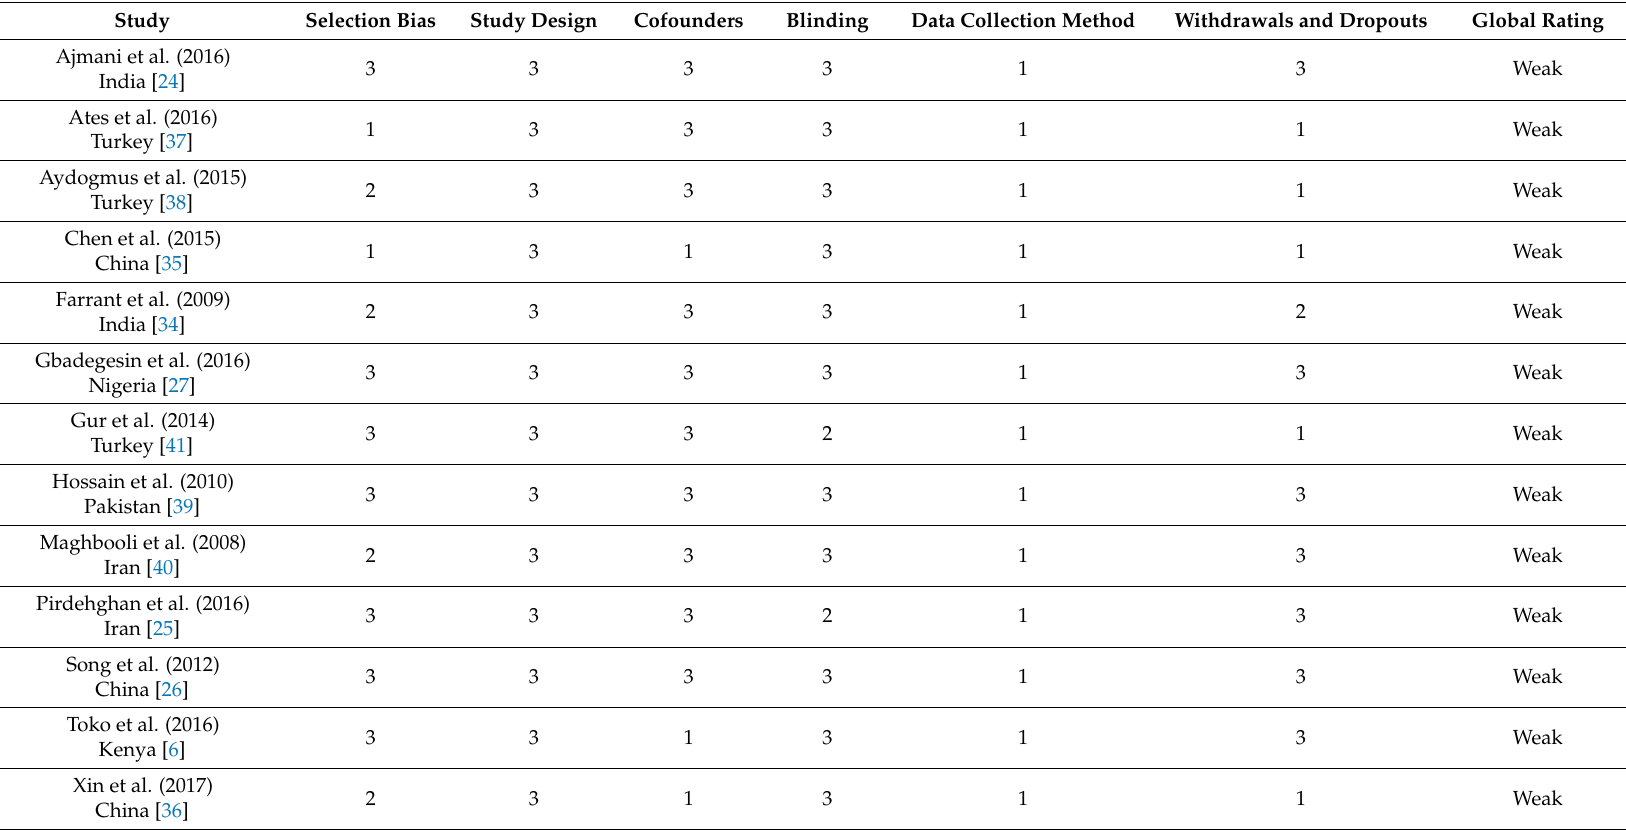
Table 3. Summary of study quality assessment ratings for included